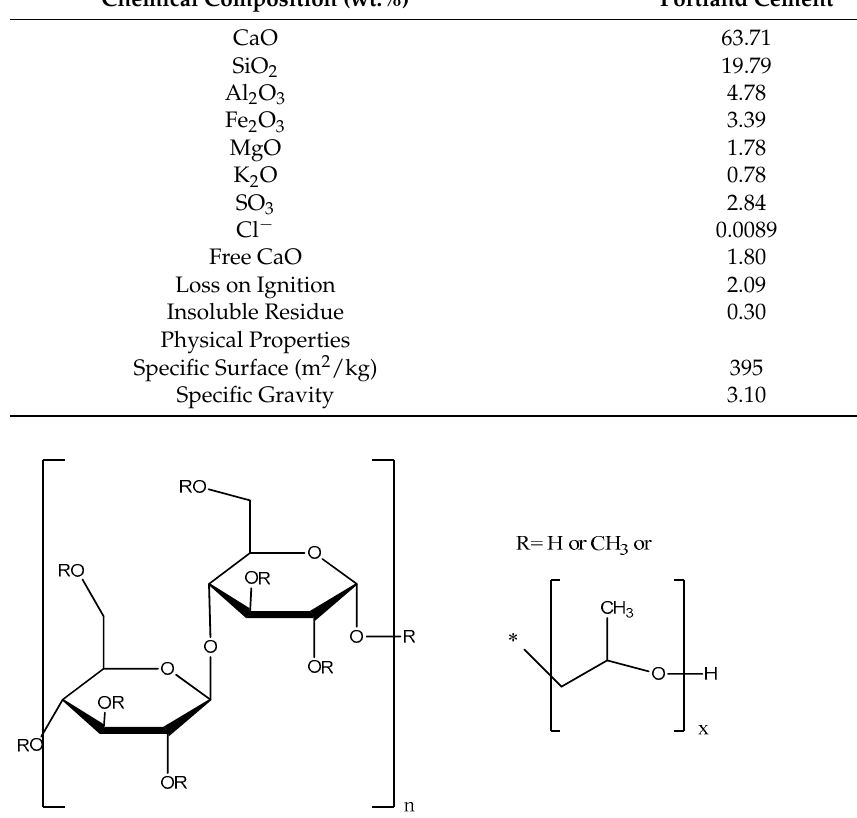
Figure 2. The generalized molecular structure of HPMC.